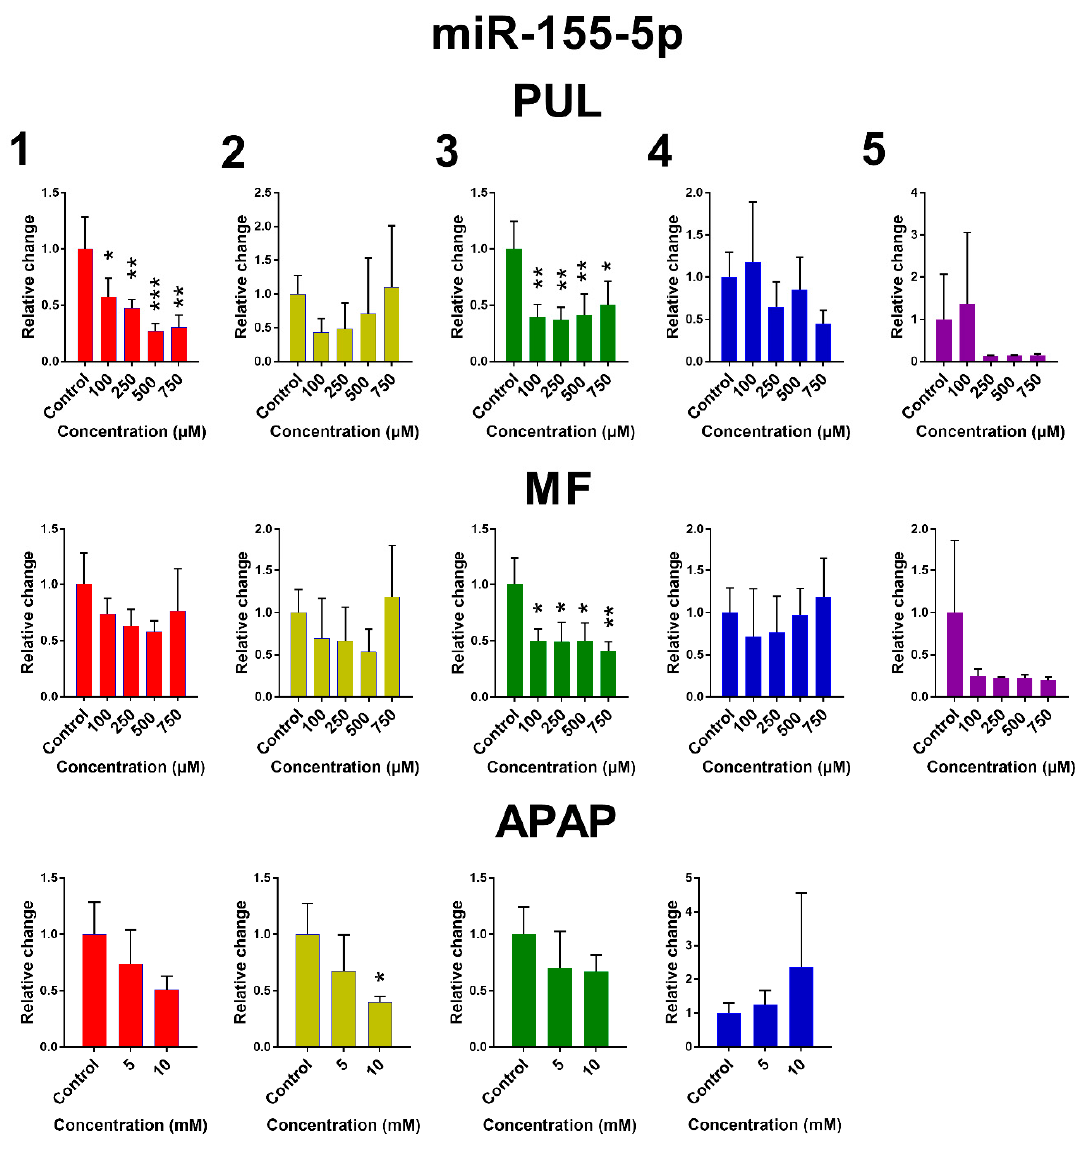
Figure 5. Cont. Figure 5.